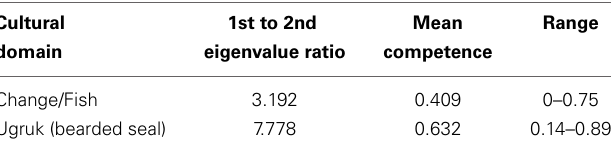
Table 4 | Comparison of the cultural consensus tests between two